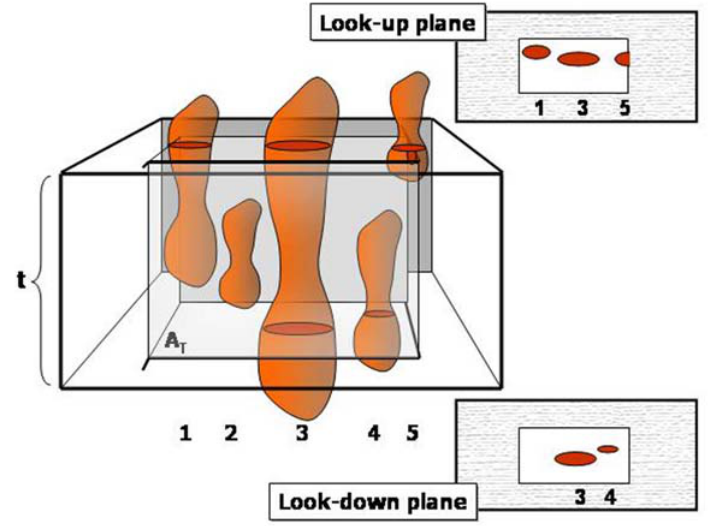
Fig. 15 – Schematic representation of the ‘‘disector’’ method. Disector is the union of a reference plane with an unbiased counting frame of area A T and a look-up plane at distance t apart. Four particles are in relation to the disector’s volume (calculated asA T x t). In the disector’s volume we consider the forbidden line (relative to A T , see Figure 13) and a forbidden plane. All particles hitting forbidden line or forbidden plane are not considered. In the example, we suggest the look-down plane as forbidden plane. In right side up and down we see the schema of the slices with the particles profiles. Up slice shows particles 1, 3 and 5. Down slice shows particles 3 and 4. In the up slice particle 5 hit forbidden line. Therefore, only particle 1 in up slice must be